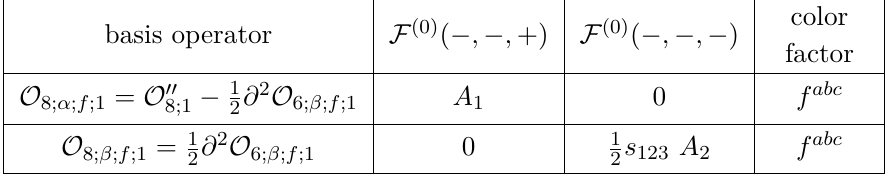
Table 12 . Final basis operators at dimension 8.